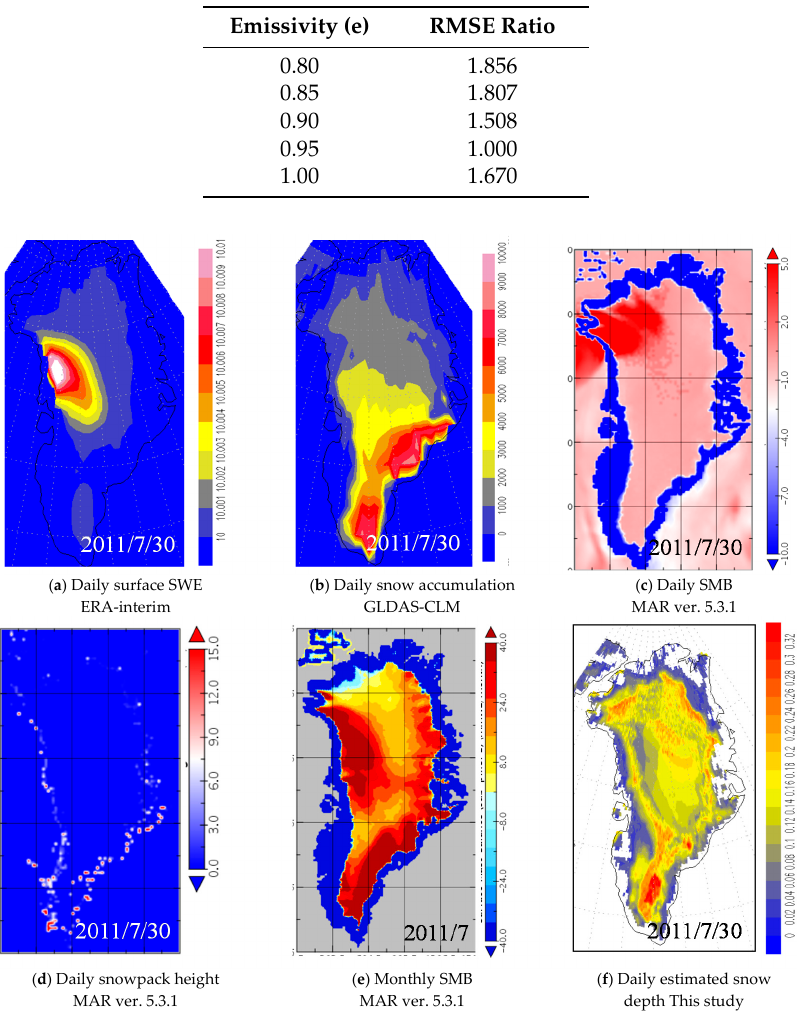
Figure 10. Daily spatial resolution on 30 July 2011 for ( a ) the daily surface snow water equivalent (SWE; m) from ERA-interim, with 0.75° spatial resolution; ( b ) the daily surface accumulation of snow (kg/m 2 ) from GLDAS-CLM, with 1° spatial resolution; ( c ) the daily surface mass balance (SMB; mm WE/day; WE = water equivalent) from MAR ver. 5.3.1 based on NCEPv1; ( d ) daily snowpack height above ice (m) from MAR ver. 5.3.1 based on NCEPv1, with 0.2° spatial resolution; ( e ) the monthly surface mass balance (SMB; mm WE/month) from MAR ver. 5.3.1, as a reference; and ( f ) daily estimated snow depth (cm) from this study, with 0.25° spatial resolution.